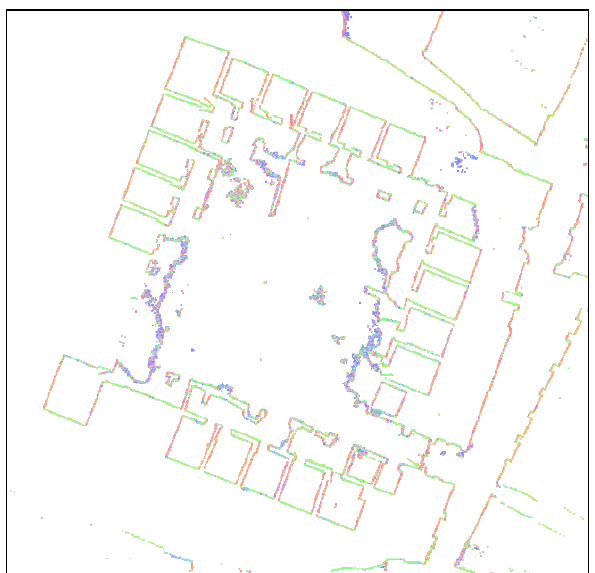
Figure 12. Floor plan section of the 1 st floor made in Revit